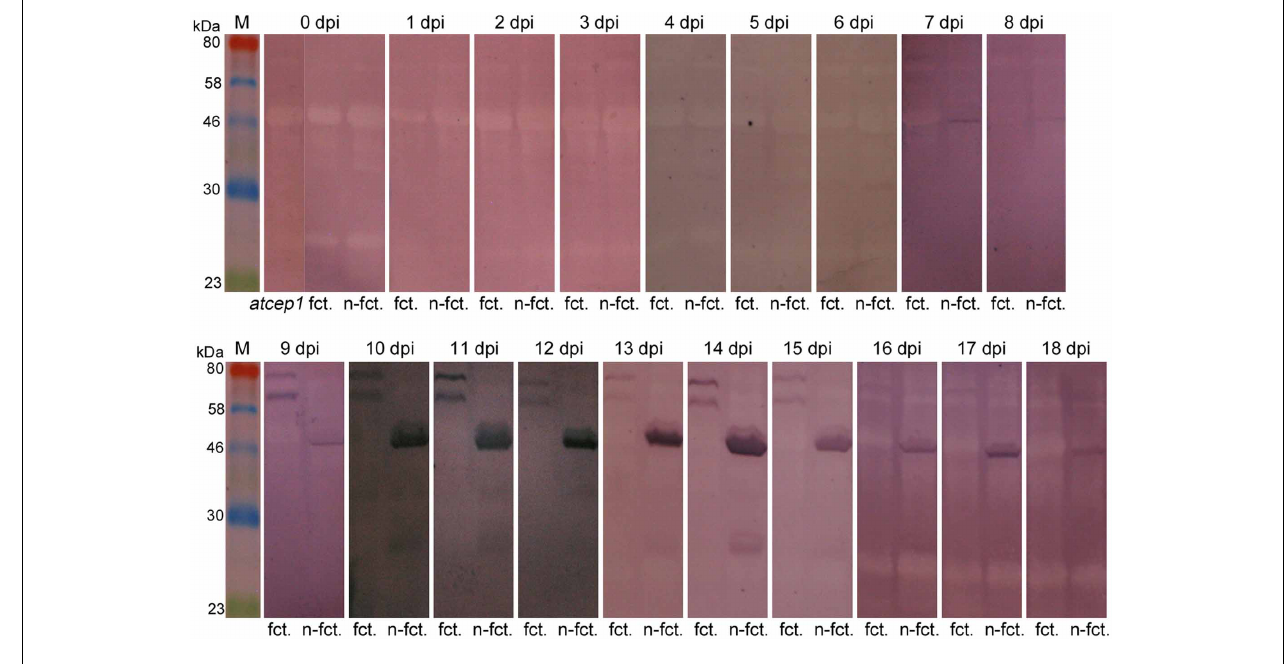
FIGURE 5 | Pro-3xHA-EGFP-AtCEP1-KDEL and pro-3xHA-EGFP-KDEL, respectively, are detectable from 9 days post inoculation (dpi) on upon leaf inoculation with Erysiphe cruciferarum . Immunoblots with anti-HA antibodies on total protein extracts from leaves of “wild type” plants ( atcep1 SAIL_158_B06 transformed with the functional construct P CEP1 ::pre-pro-3xHA-EGFP-AtCEP1-KDEL) and atcep1 knock out plants